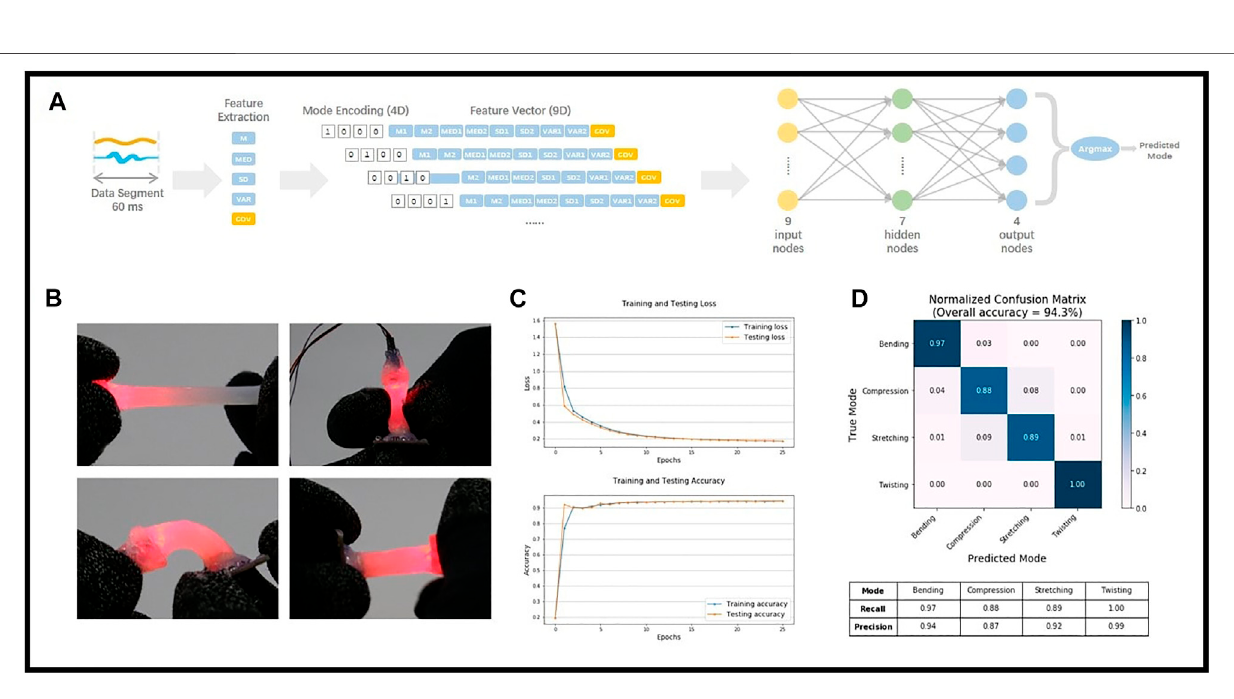
Frontiers in Robotics and AI |